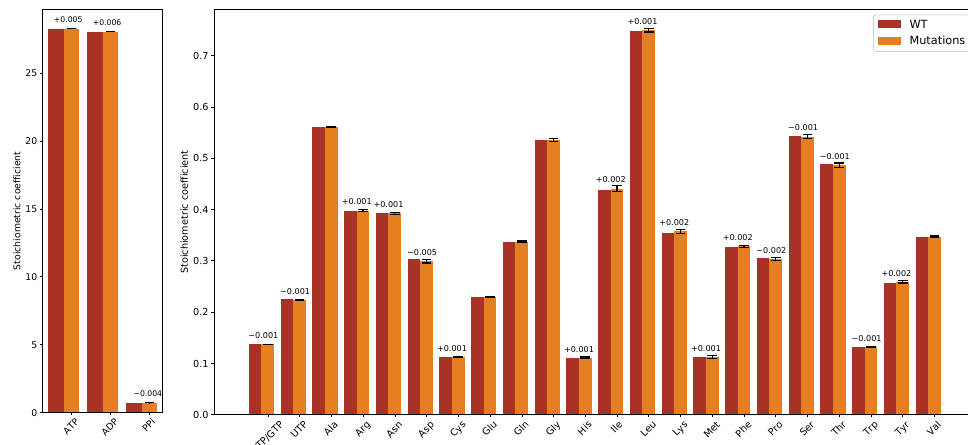
Figure 3. Difference of stoichiometric coefficients between wildtype (WT) and all mutations. The stoichiometric coefficients for all metabolites participating in the viral biomass objective function (VBOF) are compared. WT stoichiometric coefficients are indicated in red, the mean stoichiometric coefficients of all mutation variants are indicated in orange, including standard deviations (black). If the difference of the stoichiometric coefficients between WT and mutation variants was more than 0.001, the difference is indicated above the bars. The stoichiometric coefficients for the metabolites ATP, ADP and PPi, are higher compared to the other coefficients. The mutation variants’ mean coefficients show little deviation. Additionally, the differences between the stoichiometric coefficients of WT and mutation variants are very